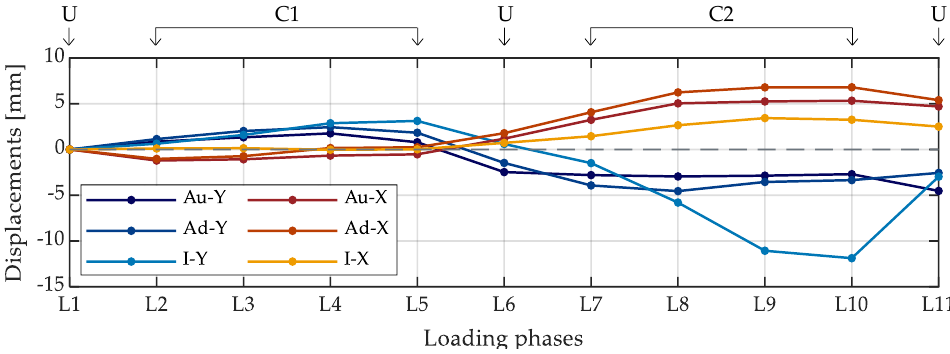
Figure 13. Horizontal longitudinal and transverse displacements of monitored supports.